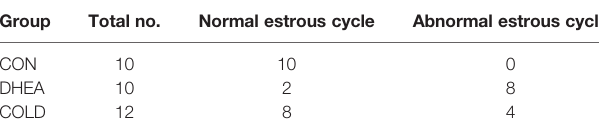
TABLE 2 | Summary of the estrous cycles. Group